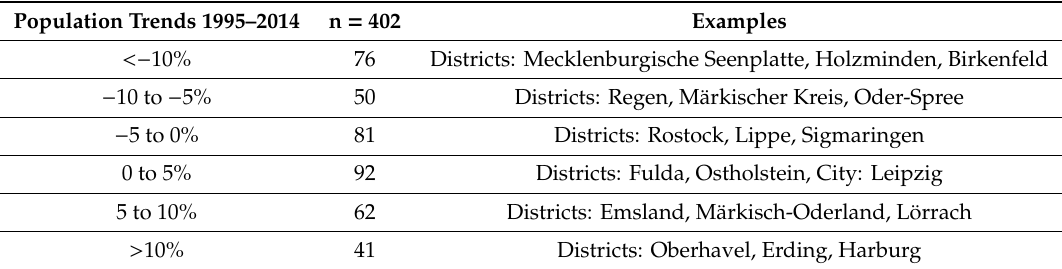
Table 2. Distribution of German districts and towns with district status according to population trends.